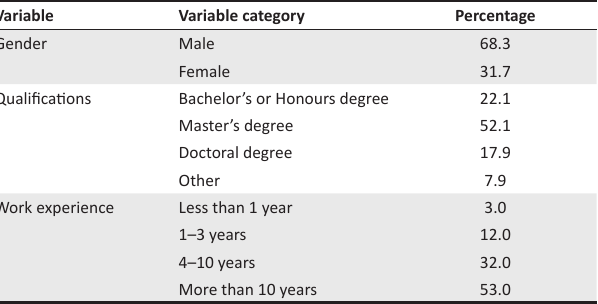
TABLE 1: Demographic data of the